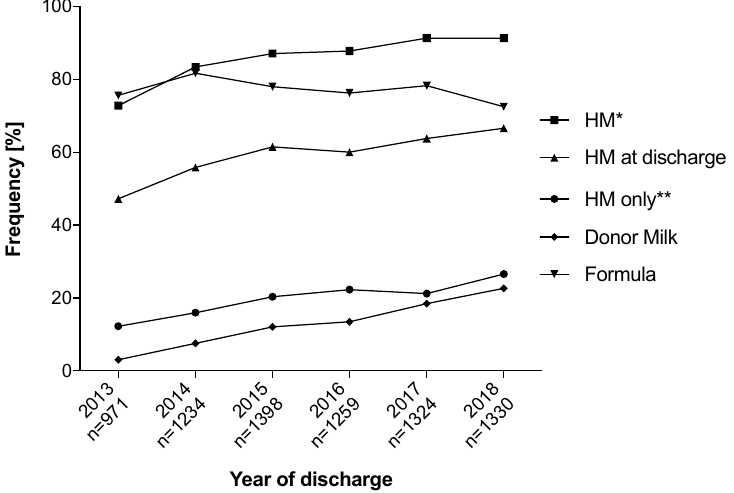
Figure 1. Changes in enteral feeding on German Neonatal Network (GNN) neonatal intensive care units (NICUs) between 2013 and 2018. HM, human milk; * includes all infants that were exposed to HM; ** includes all infants that were fed exclusively HM (own mother and/or donor).